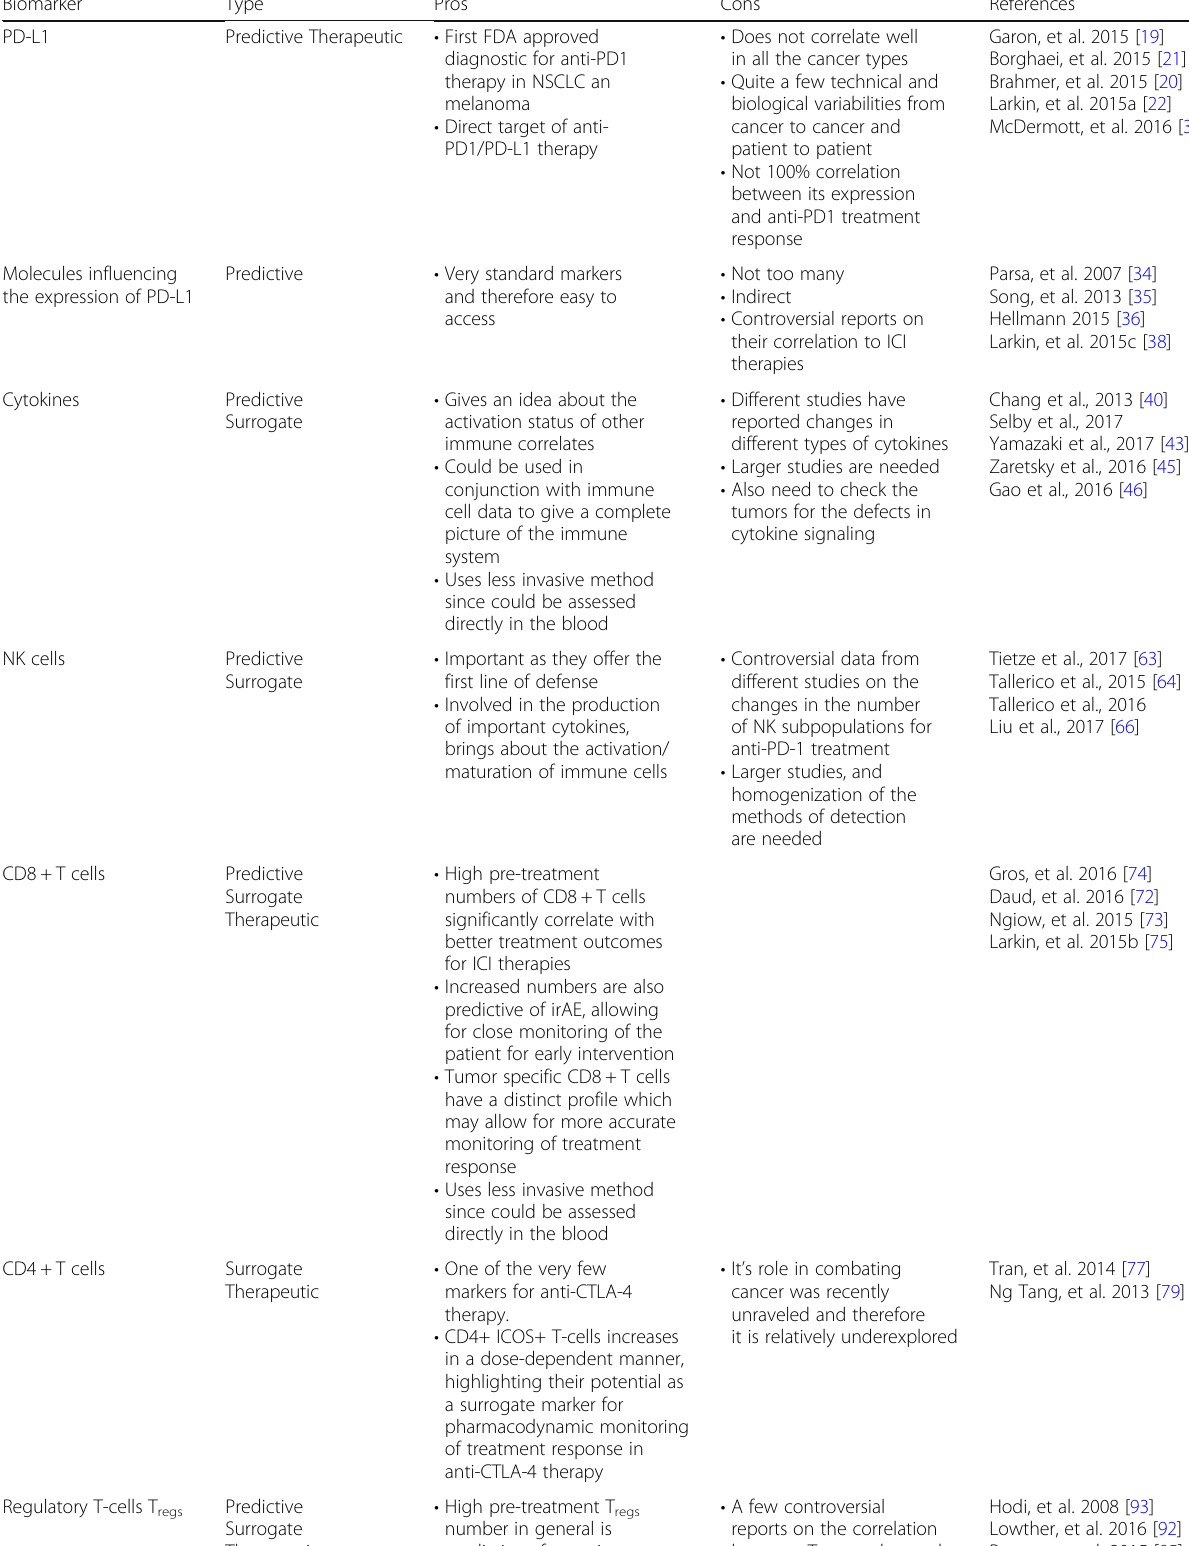
Table 1 Summary of biomarkers currently under investigation for Immune Checkpoint Inhibition (ICI) therapies